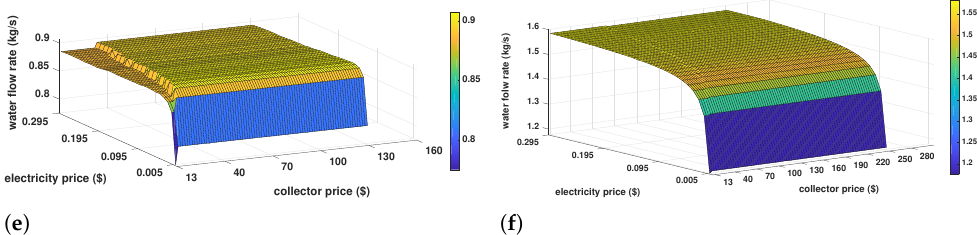
Figure 8. ( a ) Solar collector area versus both electricity and collector price (Cooling Power = 10 kW), ( b ) solar collector area versus both electricity and collector price (Cooling Power = 100 kW), ( c ) stor- age tank volume versus both electricity and collector price (Cooling Power = 10 kW), ( d ) storage tank volume versus both electricity and collector price (Cooling Power = 100 kW), ( e ) hot water mass flow rate versus both electricity and collector price (Cooling Power = 10 kW), ( f ) hot water mass flow rate versus both electricity and collector price (Cooling Power = 100 kW).